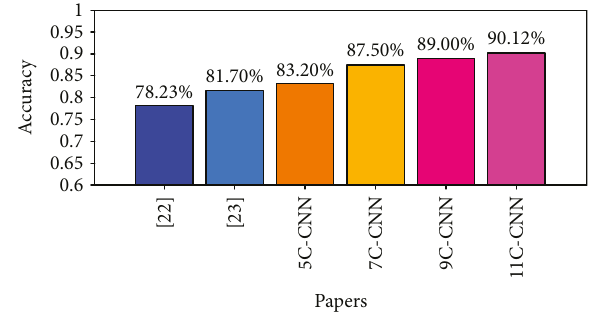
Figure 7: Accuracy comparison between two other methods and the original CNN under four kinds of channel